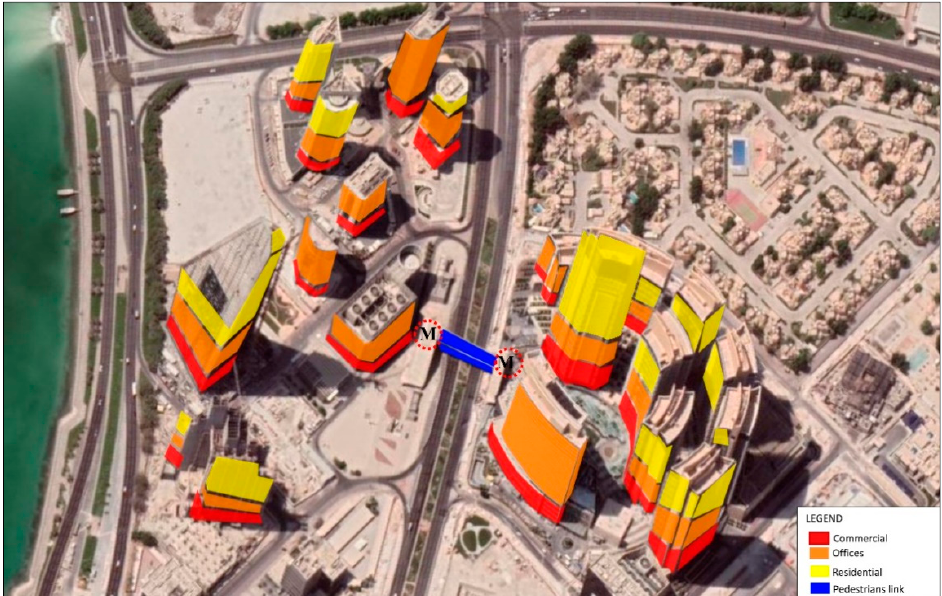
Figure 28. 3D illustration of the proposed mixed-use development. The dotted red circles with an “M” show the location of entrances to the West Bay metro station (Source: the